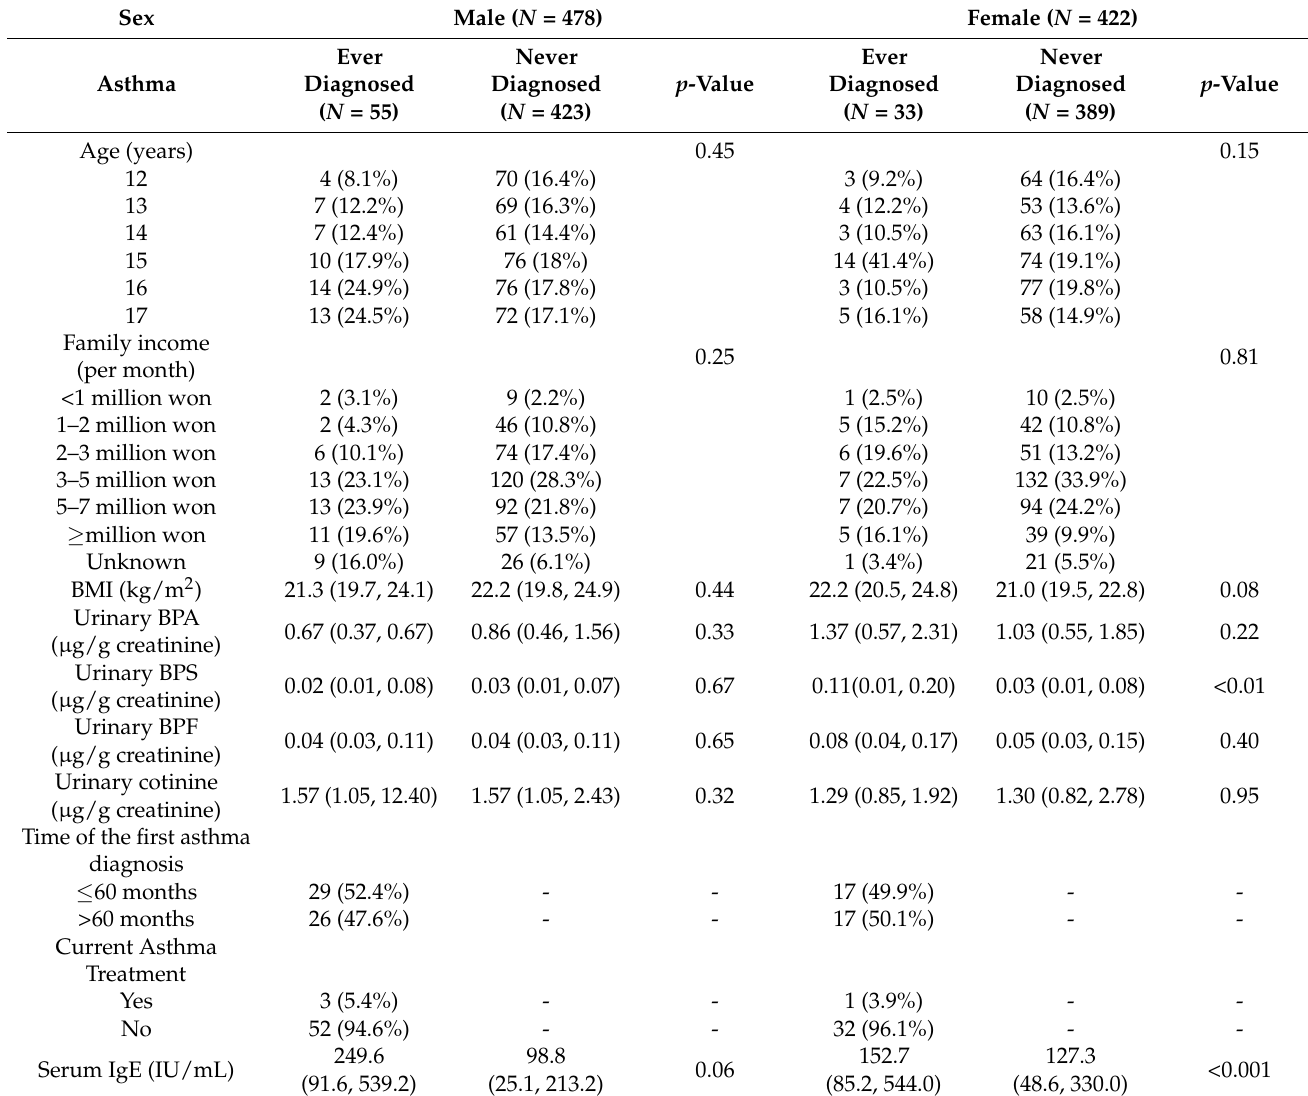
Table 1. General characteristics of study